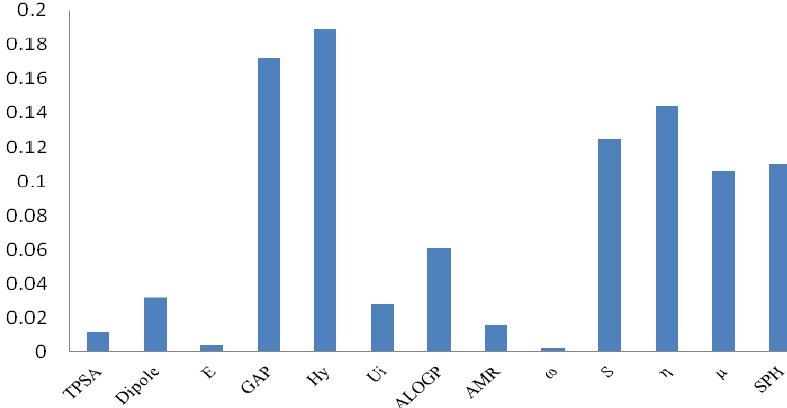
Figure 4. Descriptor weights calculated from GA